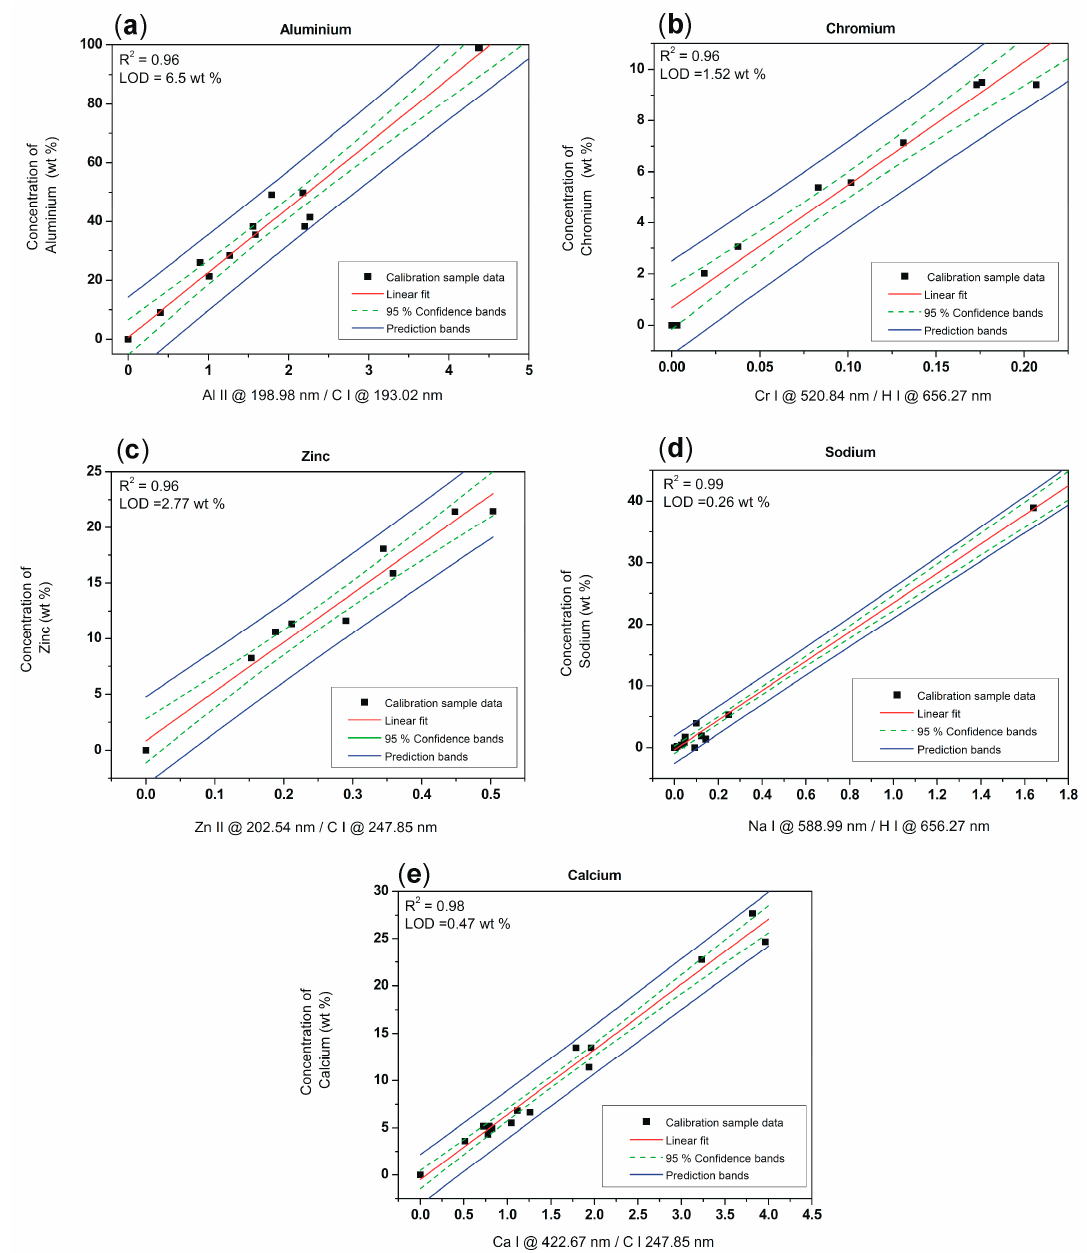
Figure 5. Calibration curves including regression parameter R 2 , limit of detection (LOD), 95% confidence limits and prediction bands for: ( a ) aluminium, ( b ) chromium, ( c ) zinc, ( d ) sodium and ( e ) calcium obtained from laboratory prepared PM calibration samples.